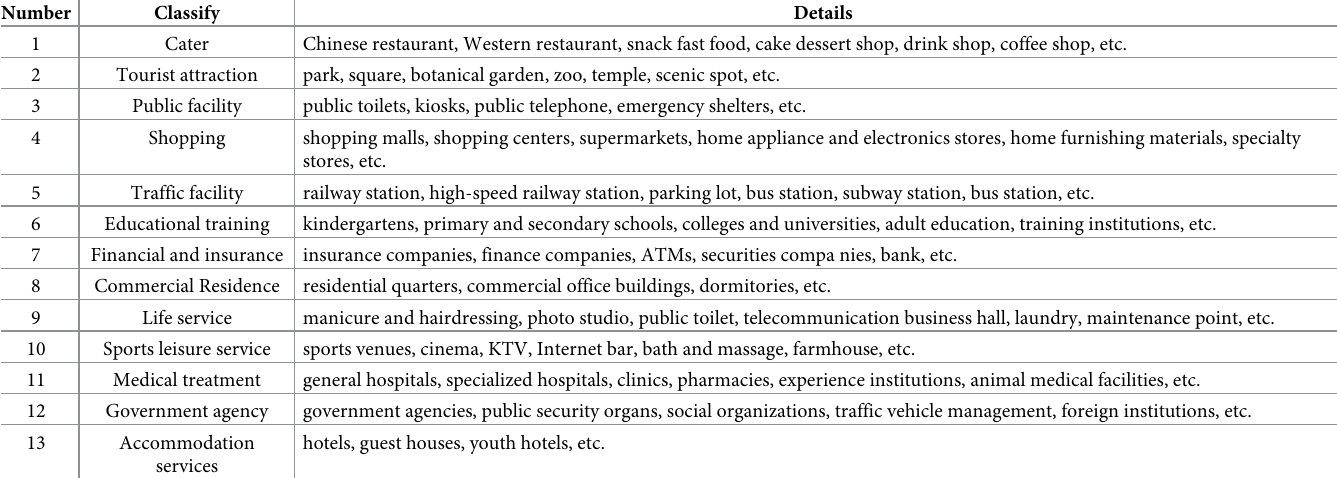
Table 2. Classification of points of interest (POIs) in this